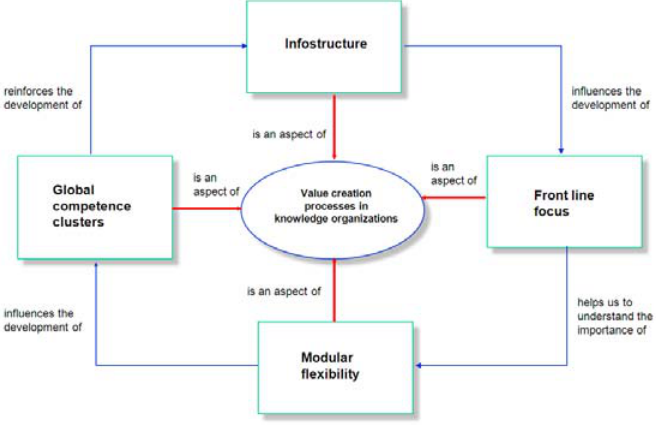
Fig. 1. Key value creation processes in the knowledge